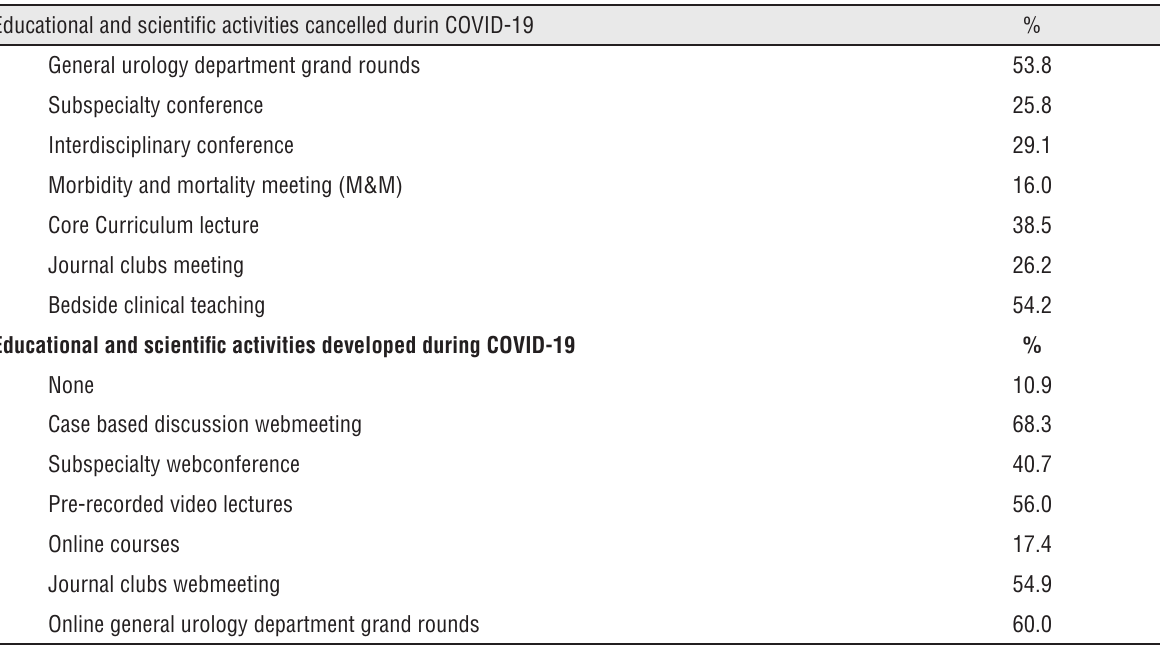
Table 2 – Impact on educational activities during COVID-19.